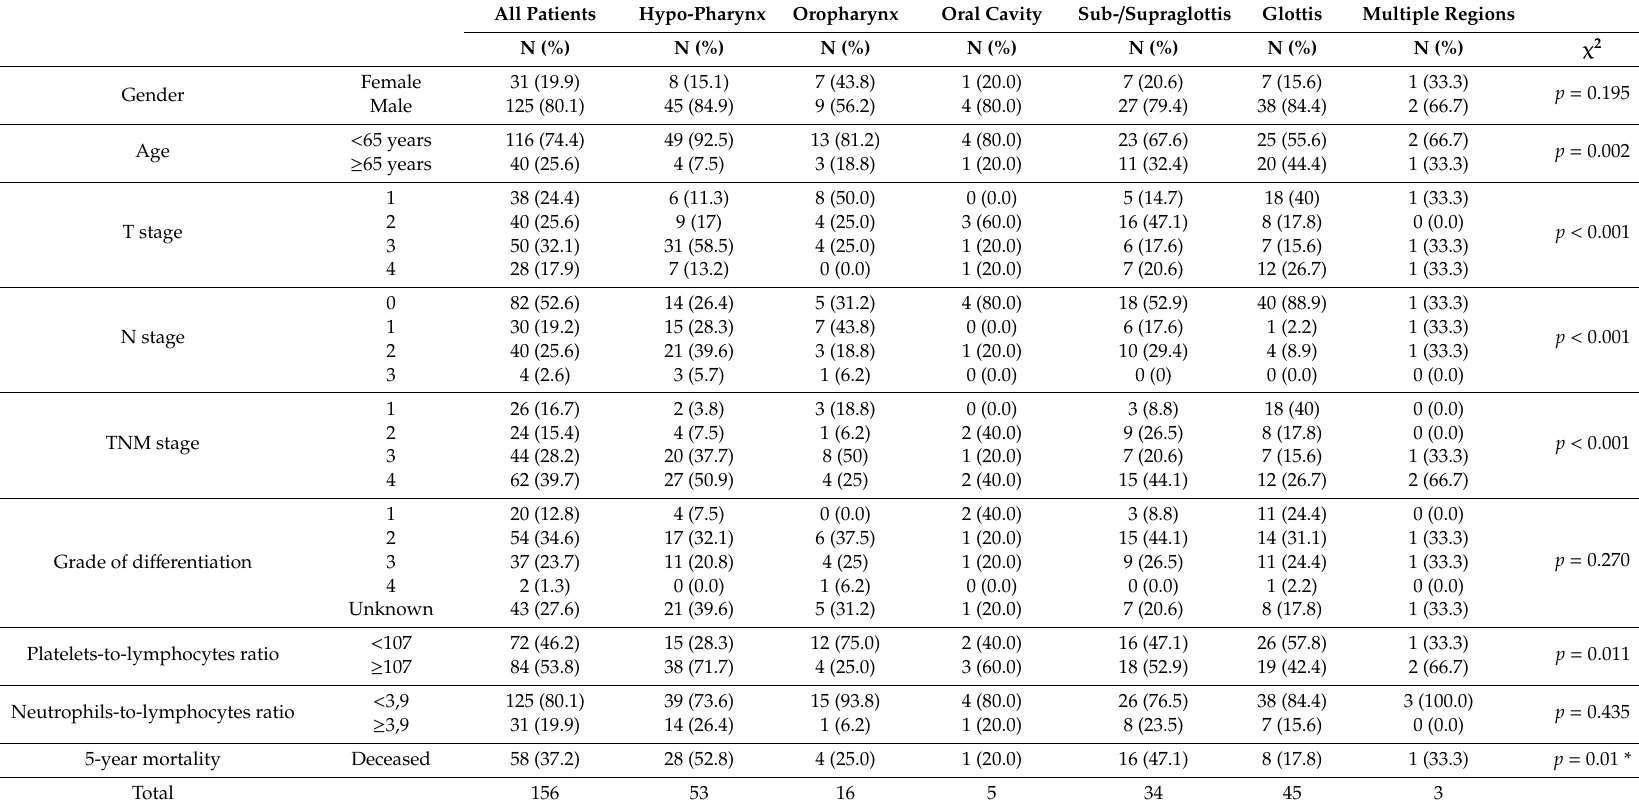
Table 1. Main patient characteristics by tumour